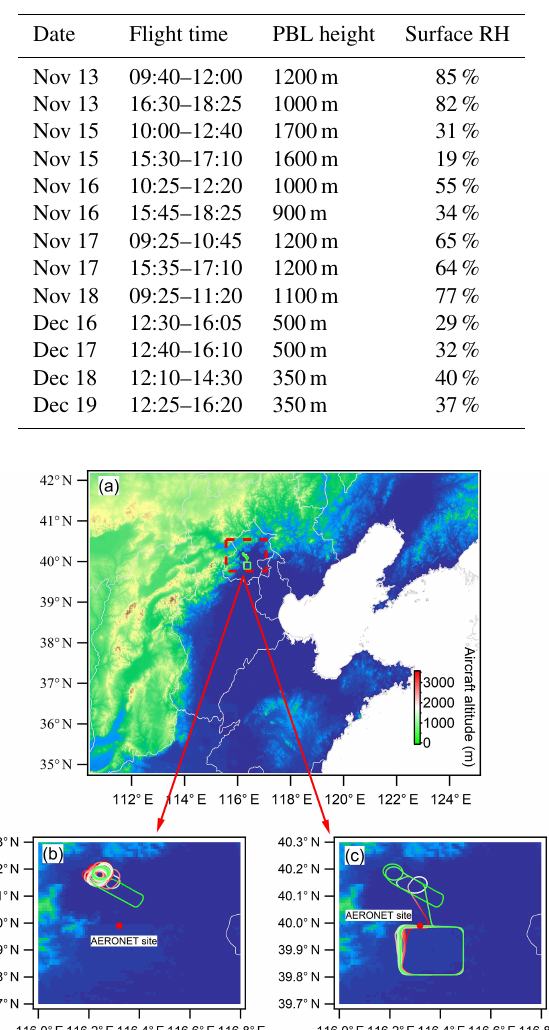
Table 1. Flight time schedules (LT, local time) and corresponding planetary boundary layer height and surface RH.